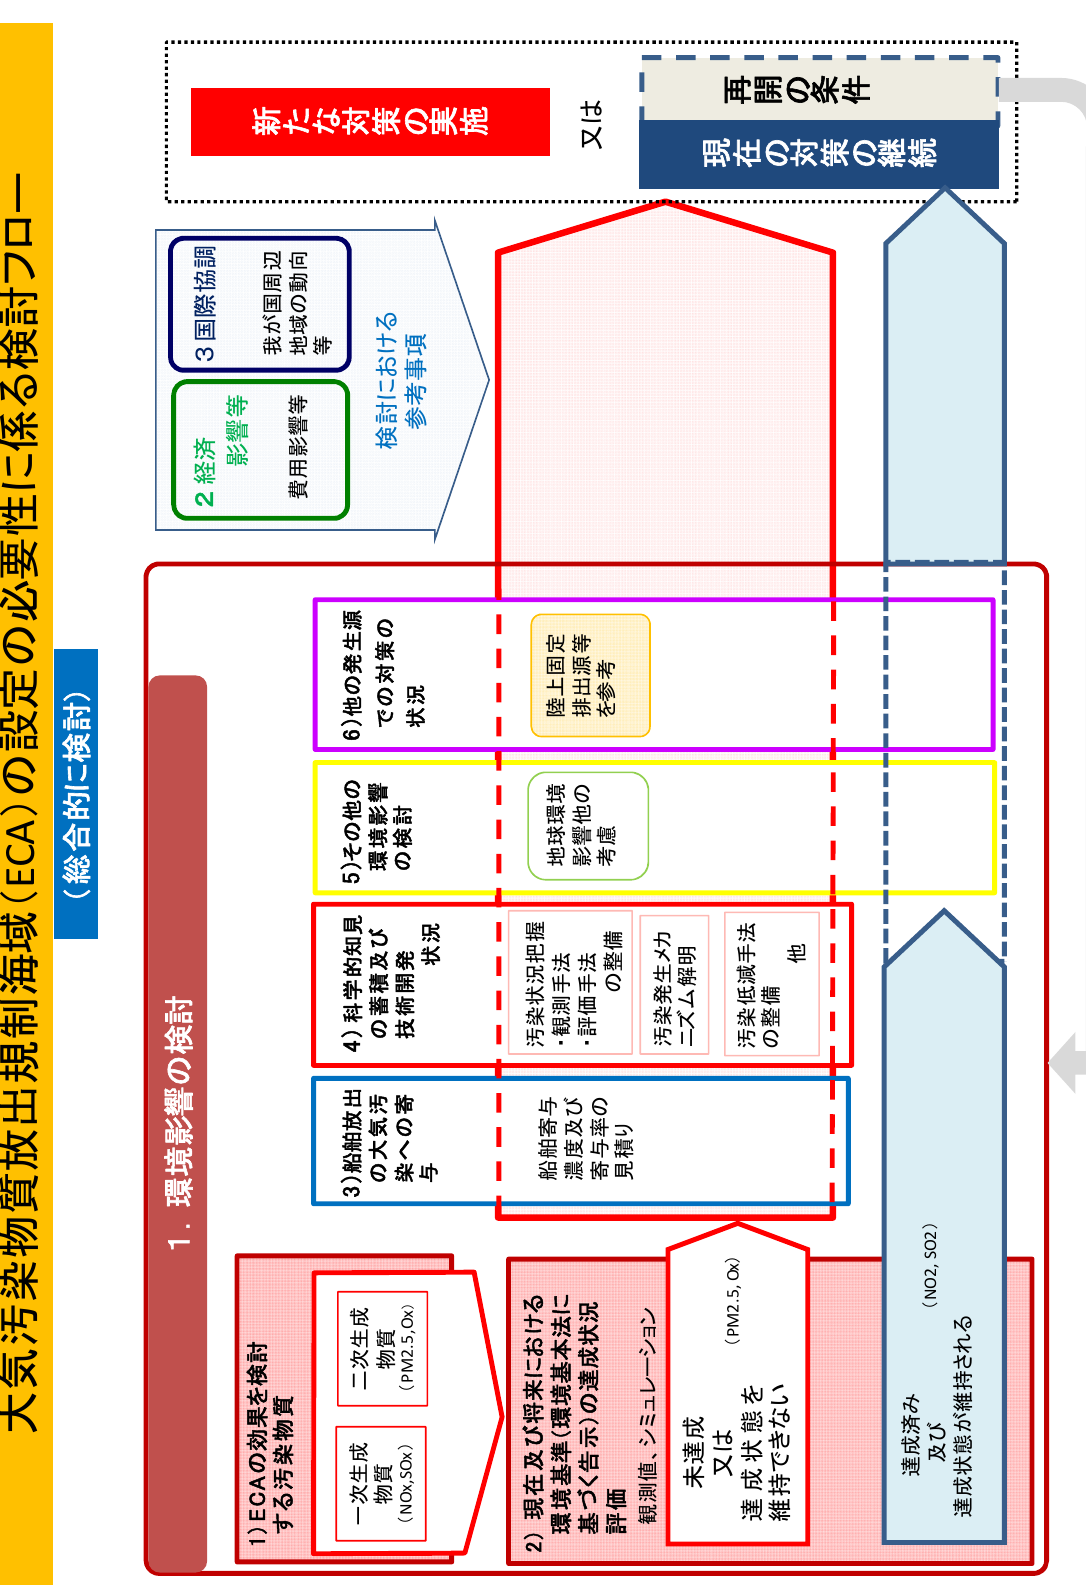
フ 検討 る 係 に 性 要 の設定の必